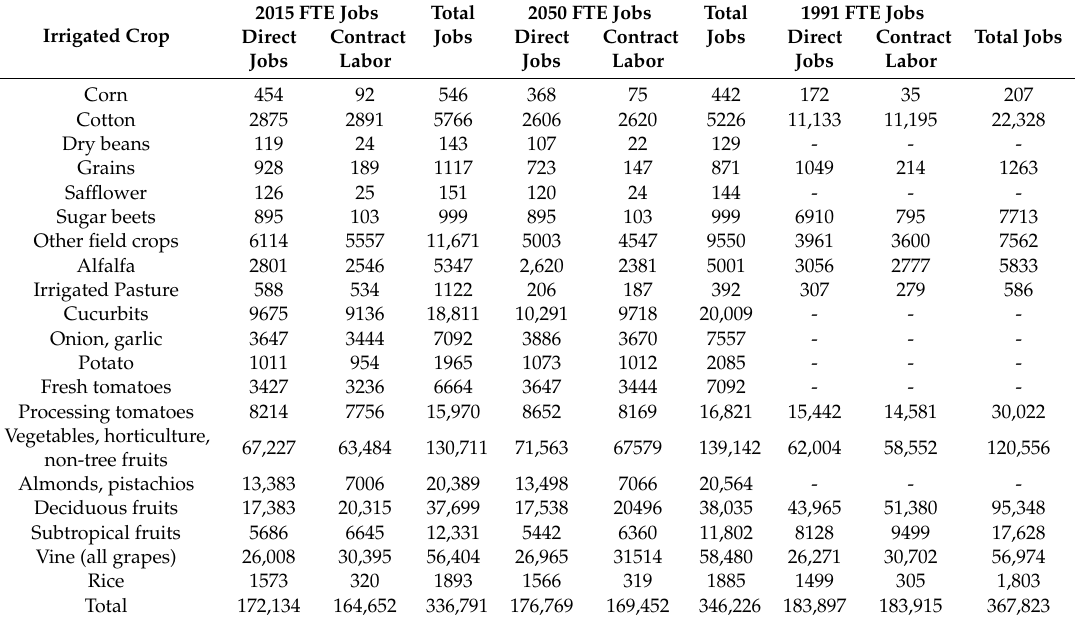
Table 2. Estimates of direct, contract, and total full time equivalent (FTE) jobs attributable to irrigated agriculture in California, 1991, 2015, and 2050. Source: Authors’ calculations using data from